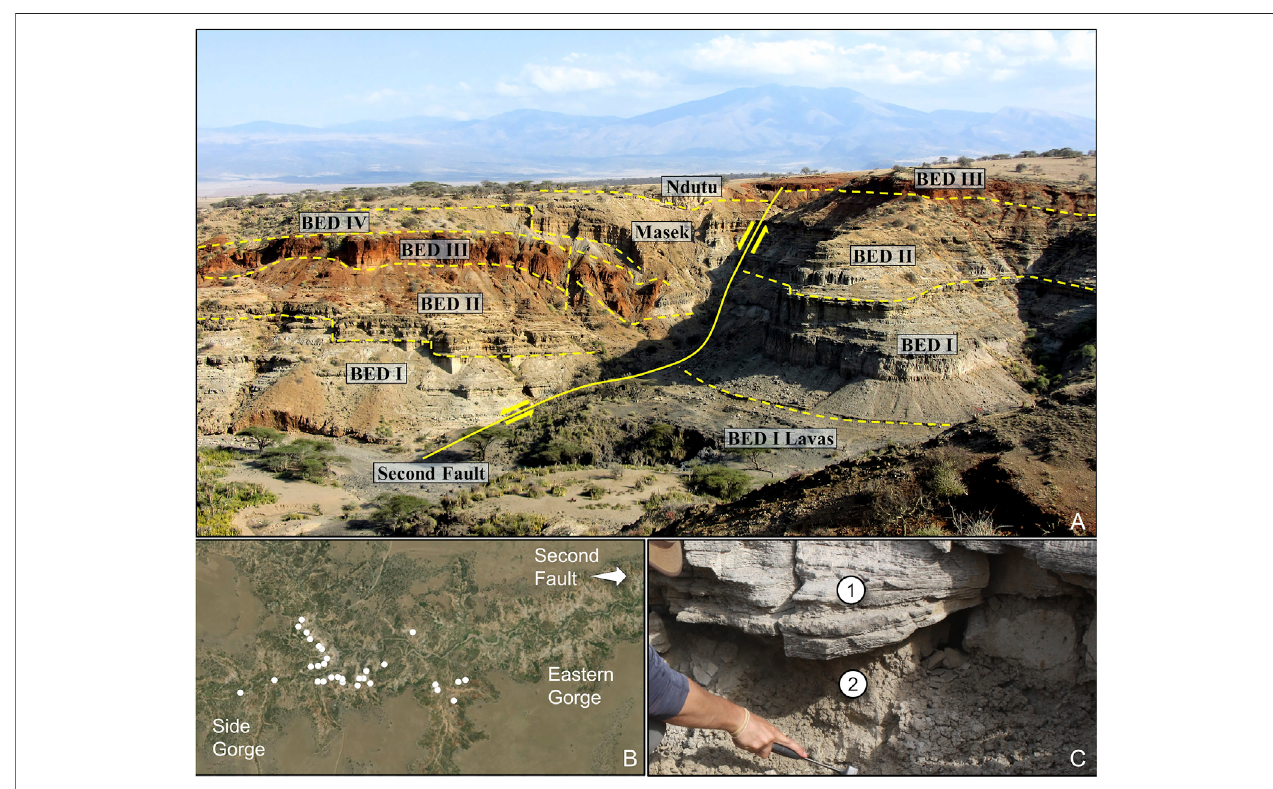
FIGURE 3 | Stratigraphic overview of Oldupai Gorge and landscape sampling for spatial habitat variability. (A) View of the Second Fault in the eastern part of the gorge and the displacement of the stratigraphic Beds. On the left (hanging wall), all beds except for Naisiusiu are exposed, while on the right (foot wall), only the Bed I Lavas and Beds I-III are visible. Exposure taken from the northern rim of the gorge facing south and encompasses ∼ 600 m east to west. Photo by Robert Patalano. (B) Locations(whitedots)aroundthemaincon fl uenceofthegorgewhereclaysincontactbelowTuffIFweresampledforplantwaxbiomarkersandphytoliths(Itambu, 2019; Patalano, 2019). (C) Example in which both Tuff IF (1) and the clays in contact below the tuff (2) are exposed. Photo by Laura Tucker.